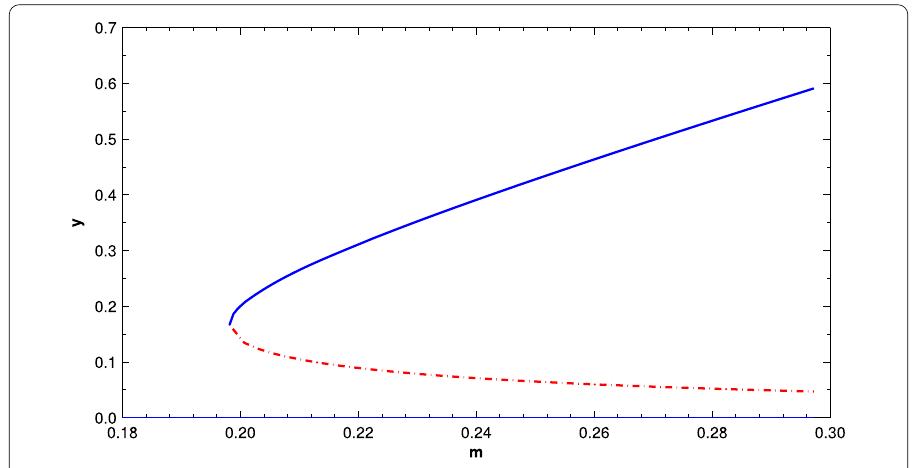
Figure 5 Bifurcation diagram for model (12) with parameter values λ = 10, μ = 0.1, β = 0.5, γ = 0.1, and h = 30. The solid curves correspond to the stable equilibria ( ¯ E 3,2 for the higher line and ¯ E 3,0 for the lower line), while the dashed-dotted horizontal line corresponds to the unstable equilibrium ¯ E